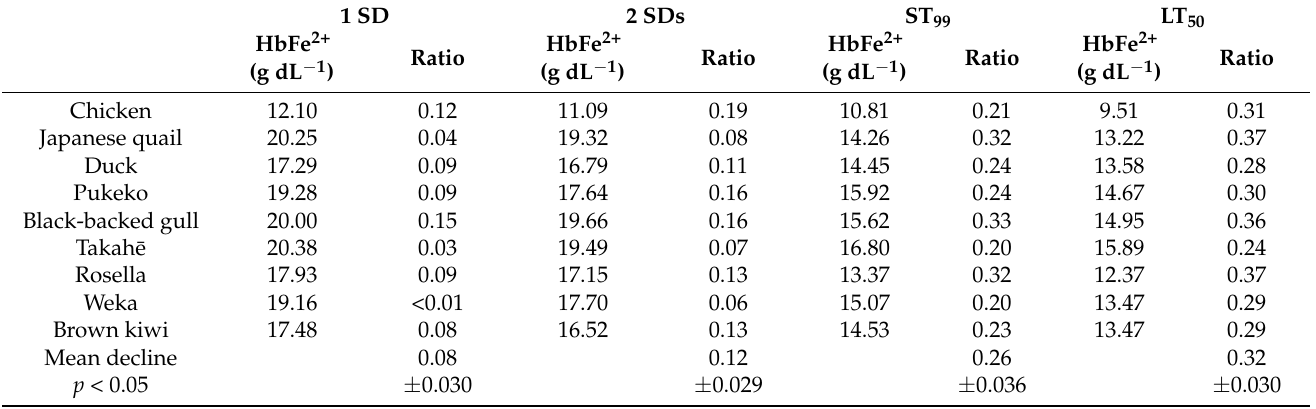
Table 3. Mean HbFe 2+ (g dL − 1 ) at 1 SD and 2 SDs relative to the T0 mean and at the ST 99 and LT 50 threshold. PAPP-induced declines in HbFe 2+ from mean T0 values are presented as a ratio for each species as well as an overall mean decline ( p <